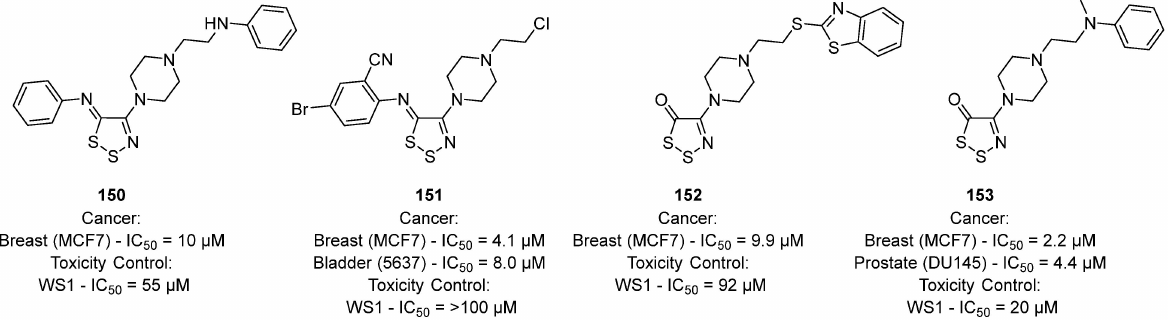
Figure 36. C4 substituted 1,2,3-dithazole analogues highlighted results from the 2021 cancer panel by our group